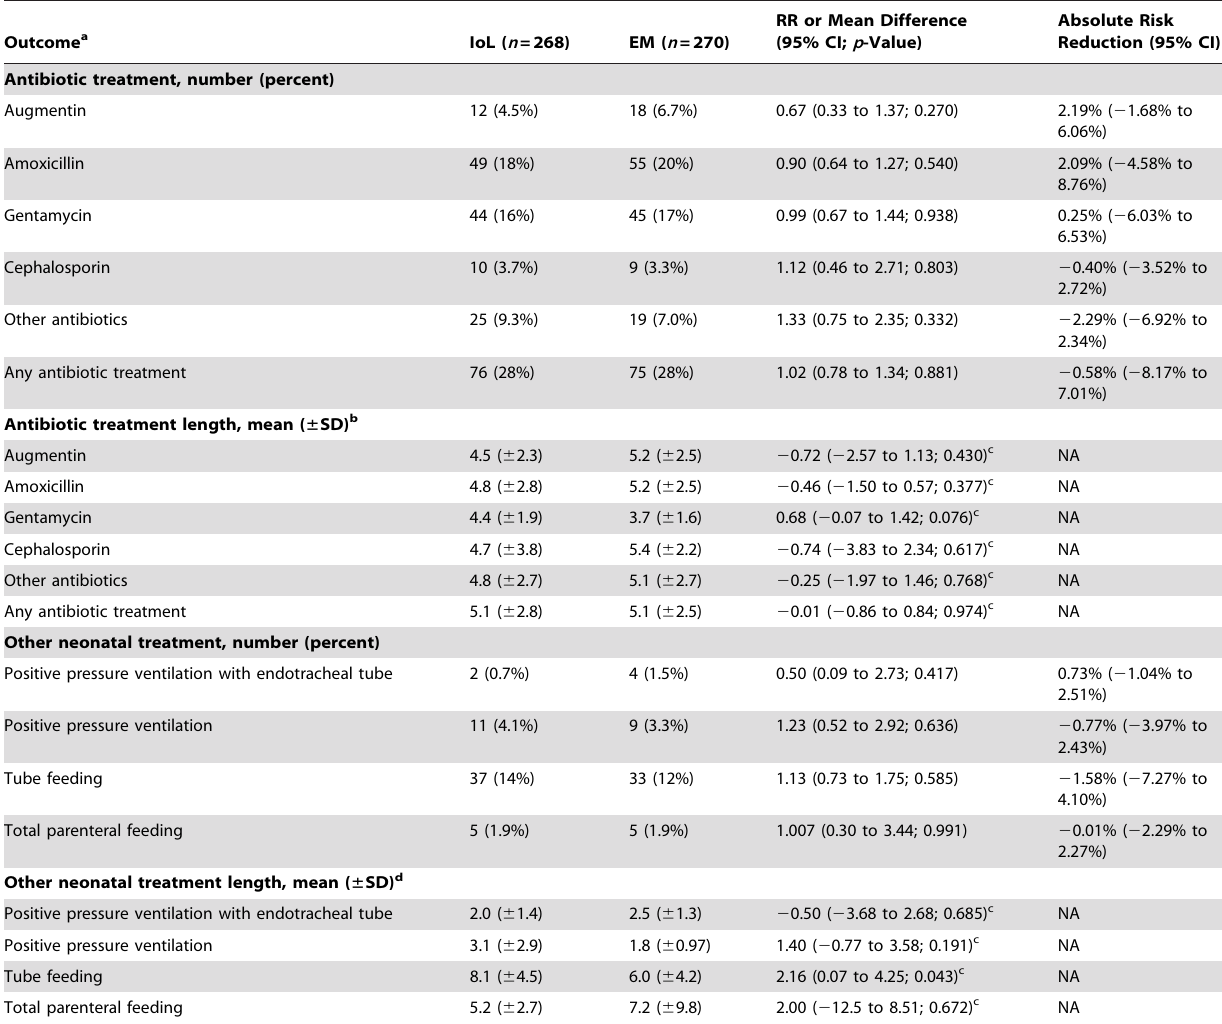
a Percentages given according to available data. b Mean treatment length calculated for neonates receiving each antibiotic. c Mean difference with 95% CI. d Mean treatment length calculated from neonates receiving each